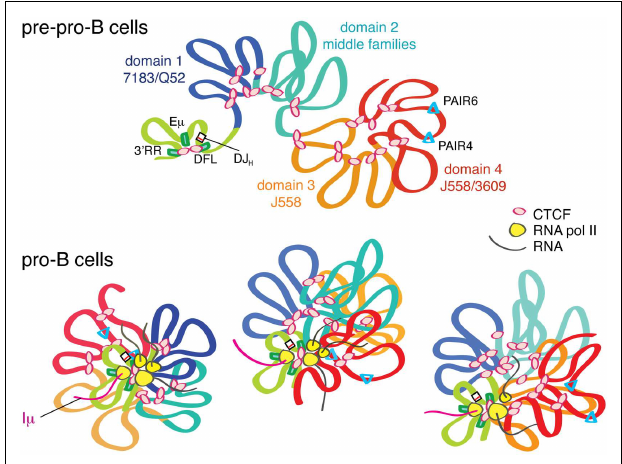
FIGURE 2 |The Igh locus undergoes locus contraction as cells develop from pre–pro-B to pro-B cells . In pre–pro-B cells, the Igh locus is in an extended conformation in a multi-loop rosette structure probably held together by CTCF. In this stage, the D, J, C genes and the enhancers are in one domain that is created by long-range looping of CTCF/DFL and CTCF/3 (cid:48) RR. E µ also interacts with these two CTCF clusters.This looping creates a D–J domain, which is physically separated from theV H genes, thus facilitating DJ H beforeV H to DJ H rearrangement. As the cells differentiate into pro-B cells, PAIR elements and other regions within theV H locus start producing RNA transcripts.Through sharing or centralization of transcriptional machinery, a transcription “factory” is formed.This gathering of all of the transcribed regions of the Igh locus in a single cell into one location, the transcription factory, will directly result in compaction of the locus because the strong I µ transcript is constantly produced from E µ , which is adjacent to DJ H .We hypothesize that different regions of the Igh locus are transcribed in different cells, and that only a subset of regions are being actively transcribed at any given moment, as depicted by the three pro-B cells in this figure.Thus, in each pro-B cell, different segments of the Igh locus are brought into proximity to the rearranged DJ H